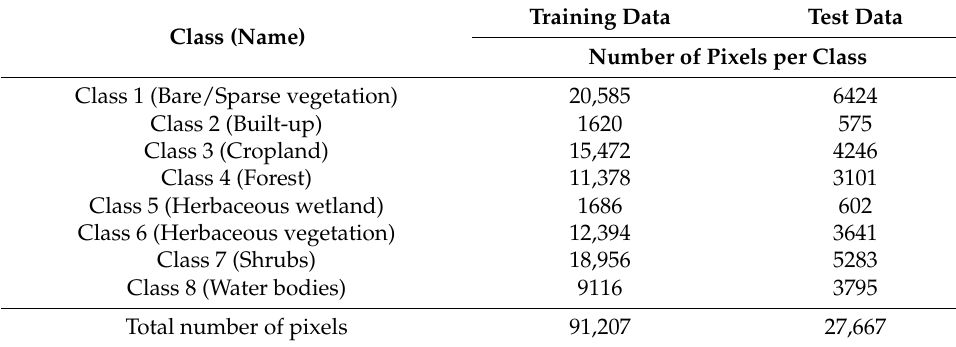
Table 3. Training and Test data per individual